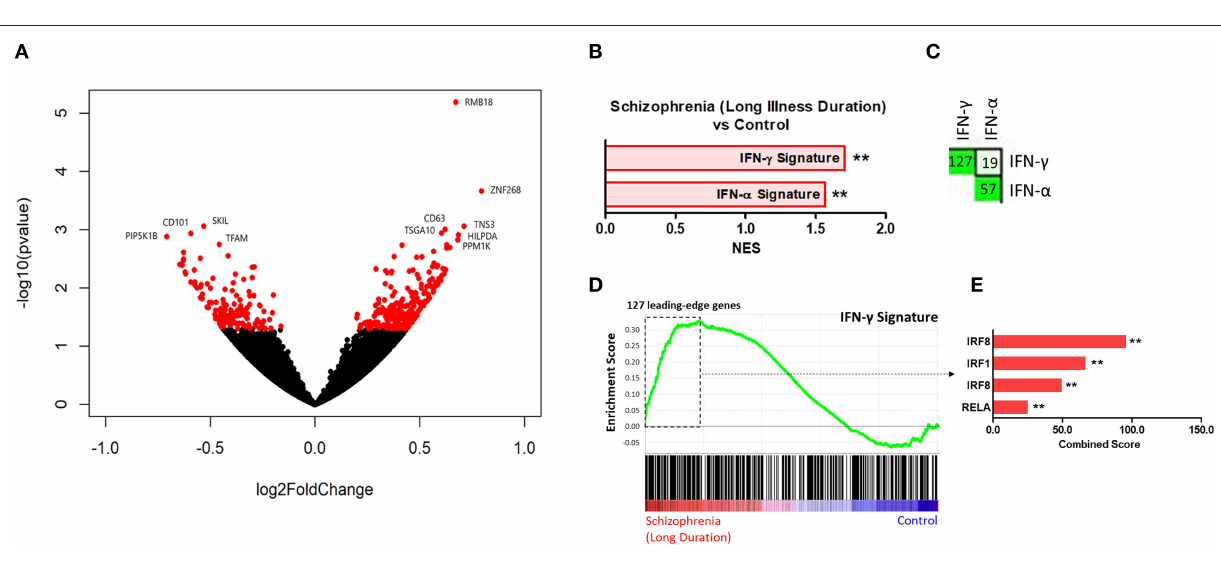
illness duration subgroup compared to controls and “hallmark_tnfa_signaling_via_nfkb” in the medium compared to long illness duration subgroups ( Supplementary Table 1